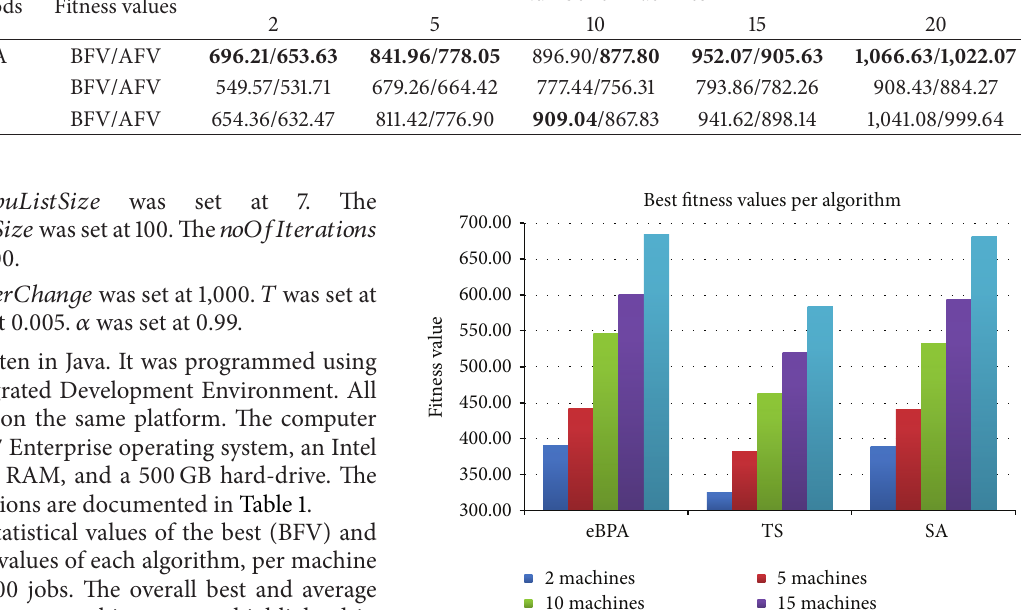
Table 3: Statistics of the best fitness values (BFV) and average fitness values (AFV) for the class of 1,500 jobs. Number of jobs Methods Fitness values